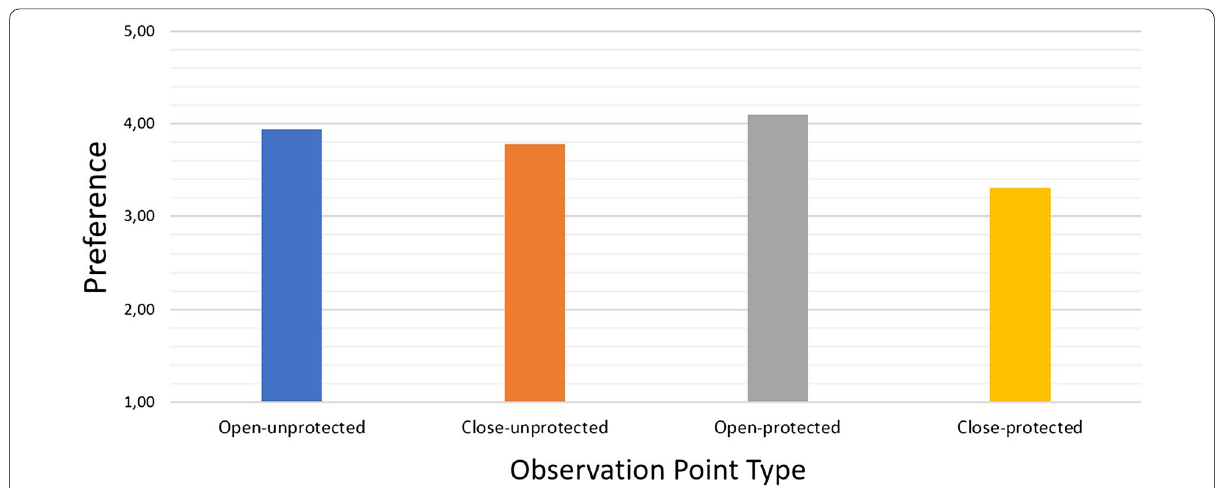
Fig. 4 Mean scores of the predefined